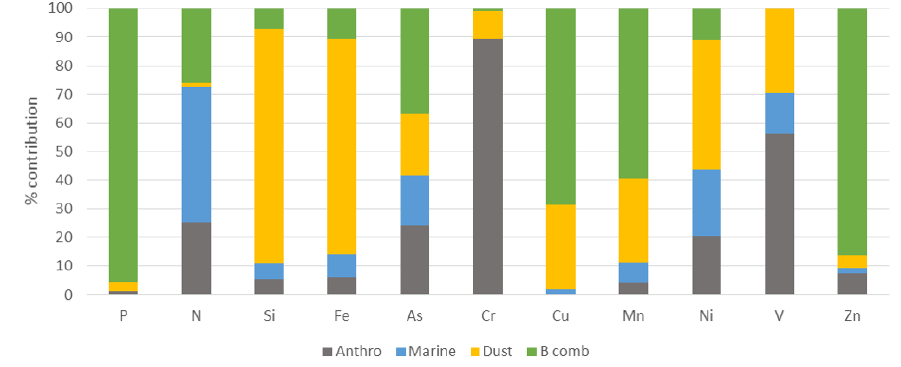
Figure 6. Relative contribution of each of the four identified factors (anthropogenic (Anthro), marine, dust, and biomass combustion (B comb)) to the “background” mass fluxes of nutrients and TMs (i.e., excluding the 12 most intense African dust deposition samples out of 195